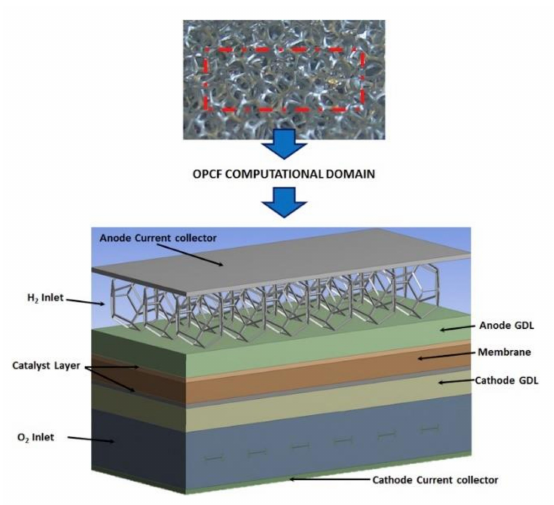
Figure 2. PEM fuel cell with open pore cellular foam material permission to reproduced